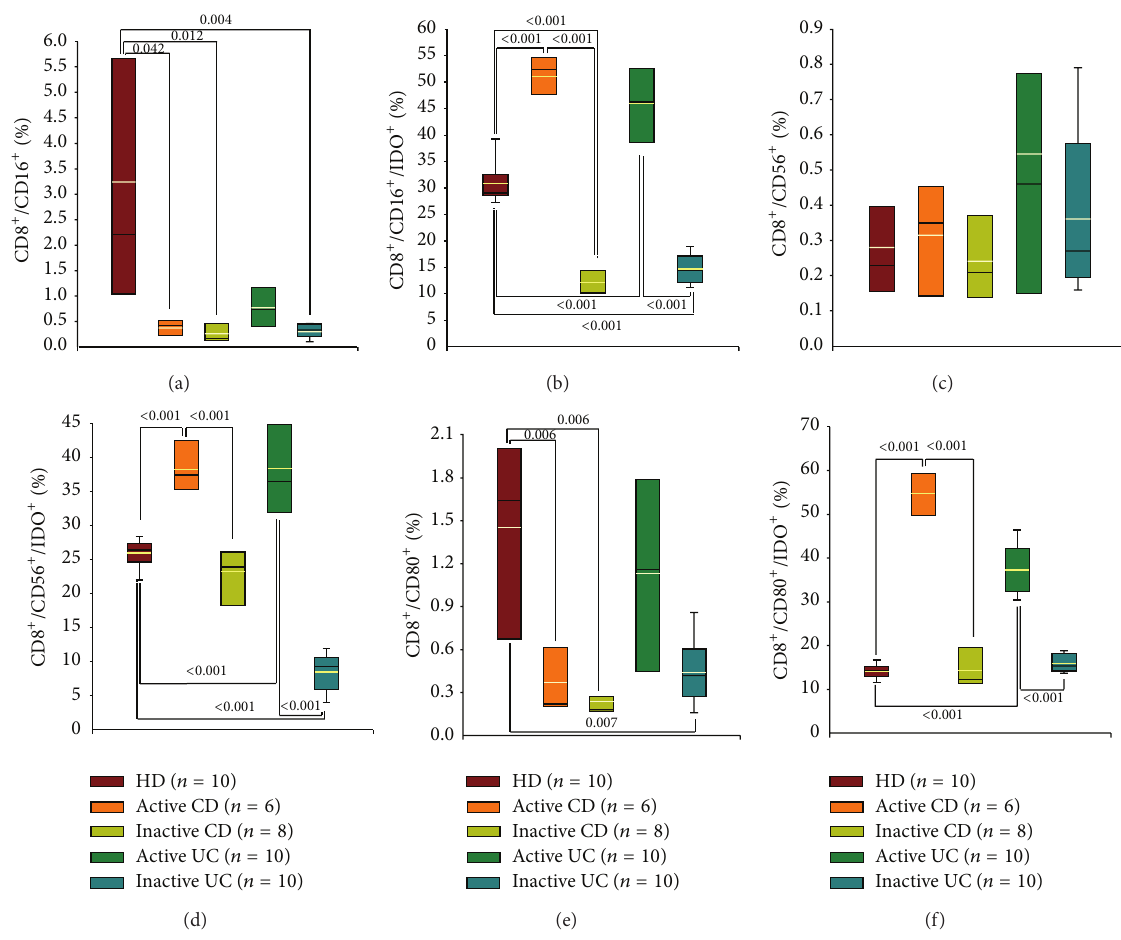
Figure 4: Percentage of IDO-expressing circulating cells in IBD (UC and CD) patients. Bar graphs show percentage of (a) CD16 + /CD8 𝛼 +